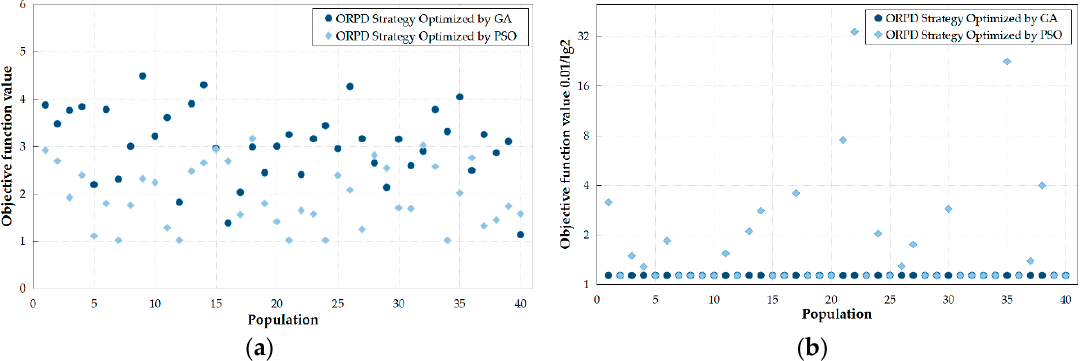
Figure 12. Convergence trend of the algorithms. ( a ) The initial solution space of the GA and PSO algorithm; ( b ) The final solution space of the GA and PSO algorithm.